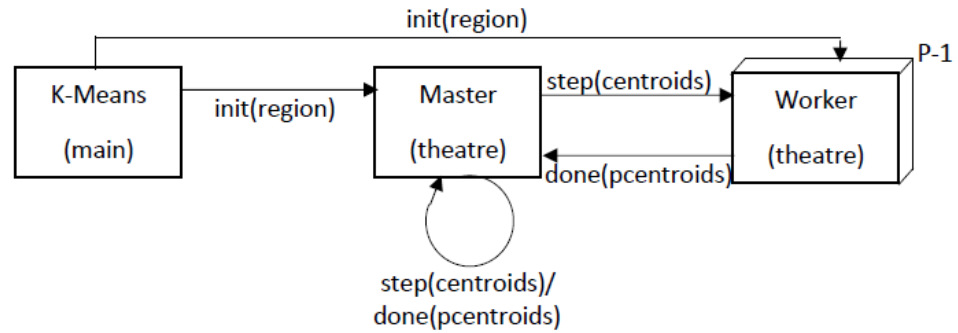
Figure 6. Master/worker organization of Theatre-based